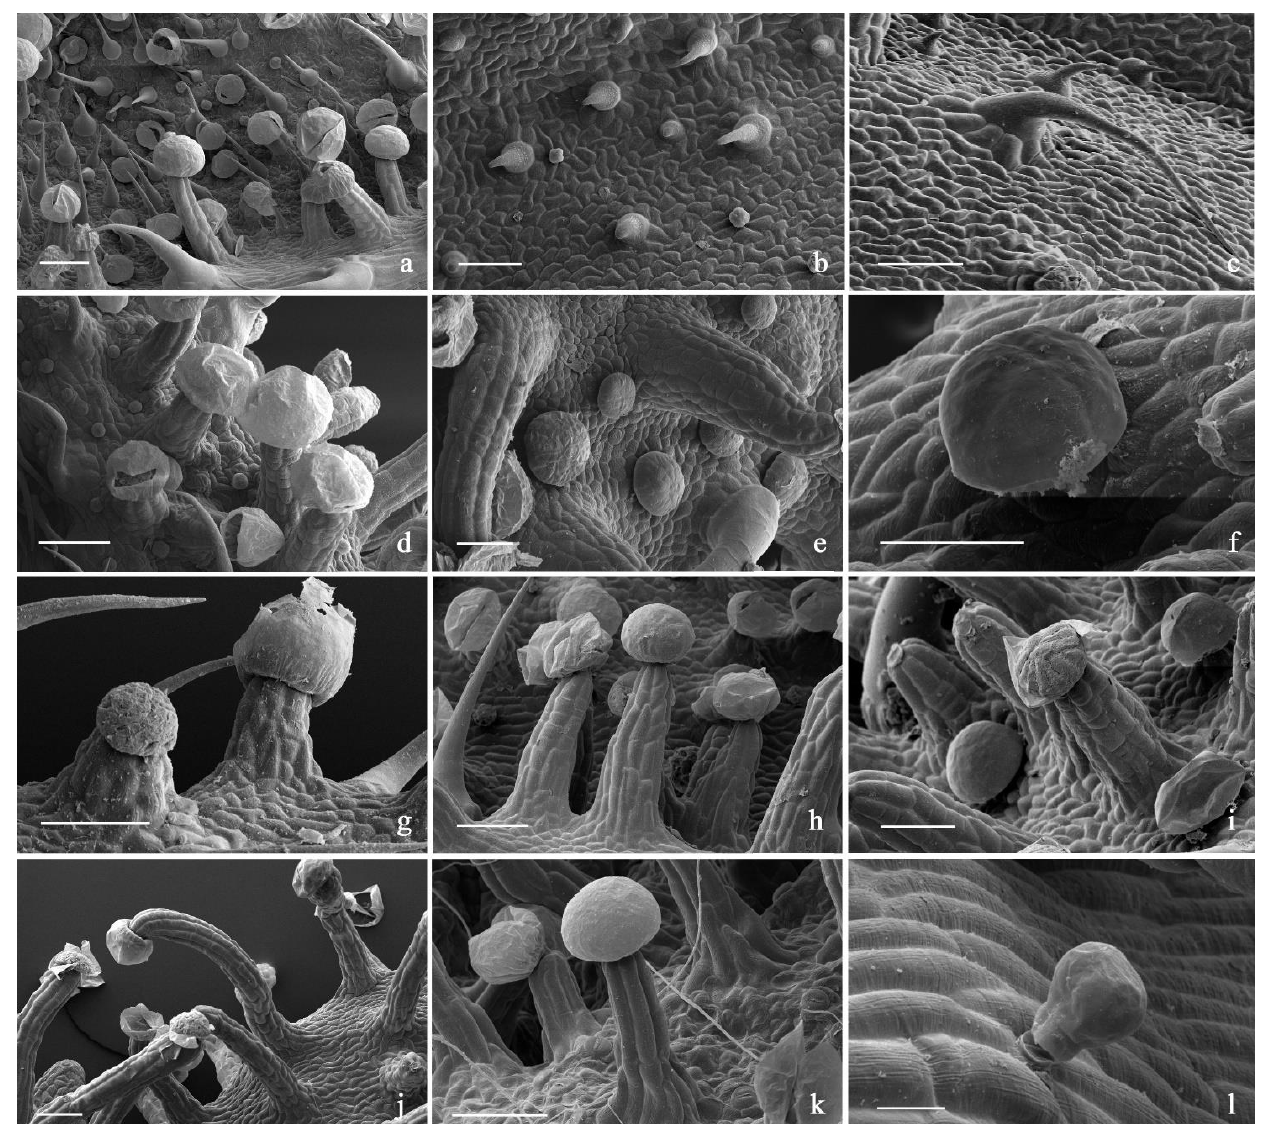
Figure 7. SEM micrographs showing the trichome morphotypes in the investigated C. sativa varieties. ( a ) General view of the bract abaxial surface with hair-like lithocysts, capitate-stalked, capitate-sessile and bulbous trichomes; ( b ) short hair-like lithocysts; ( c ) long hair-like lithocysts; ( d ) particular with groups of capitate-stalked and bulbous trichomes; ( e , f ) capitate-sessile trichomes; ( g – k ) capitate-stalked trichomes with diverse elongation degree of the pseudo-stalk; ( l ) bulbous trichome. Scale bars = 100 µm (a – k); 20 µm (l).